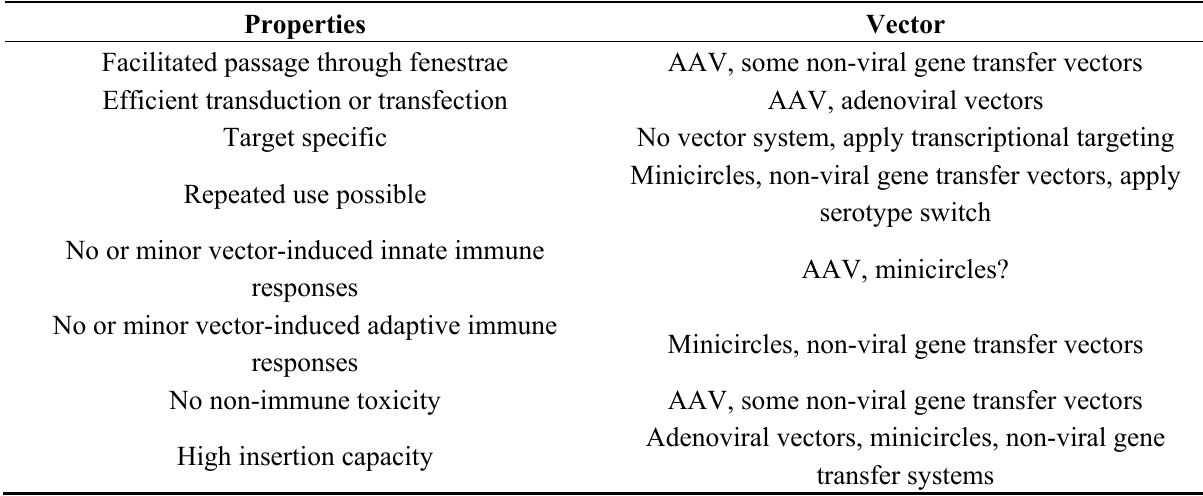
Table 1. Characteristics of the ideal vector for hepatocyte-directed gene